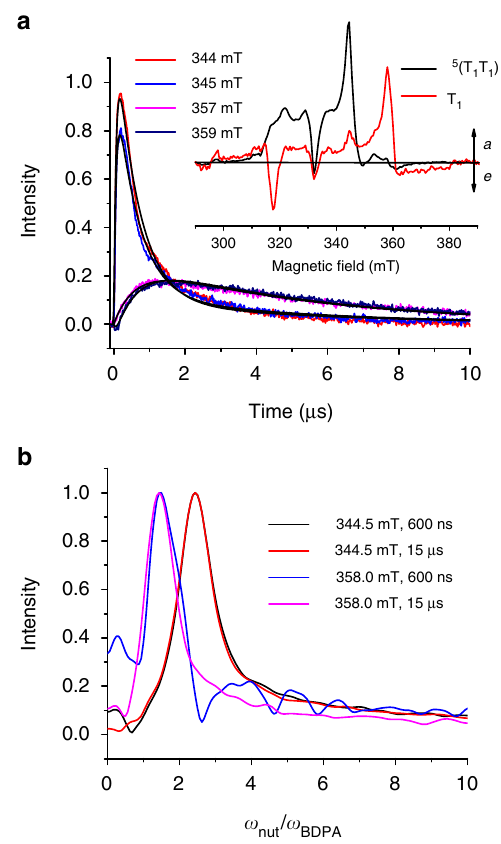
Figure 5 | Transient EPR data. ( a ) TREPR kinetics for the formation and decay of the 5 (T 1 T 1 ) and (T 1 þ T 1 ) states for NC at 105K in butyronitrile measured at the indicated magnetic field values corresponding to the species-associated spectra of the 5 (T 1 T 1 ) and separated T 1 states shown in the inset. Black lines superimposed on the kinetic traces are the fits to the data using the model described in Fig. 3. ( b ) Echo-detected transient nutation spectra of NC collected at 5K in butyronitrile following photoexcitation at 640nm with a 7ns, 3mJ laser pulse. The frequency axis was normalized to the nutation frequency of an S ¼ ½, BDPA, radical standard collected under the same experimental